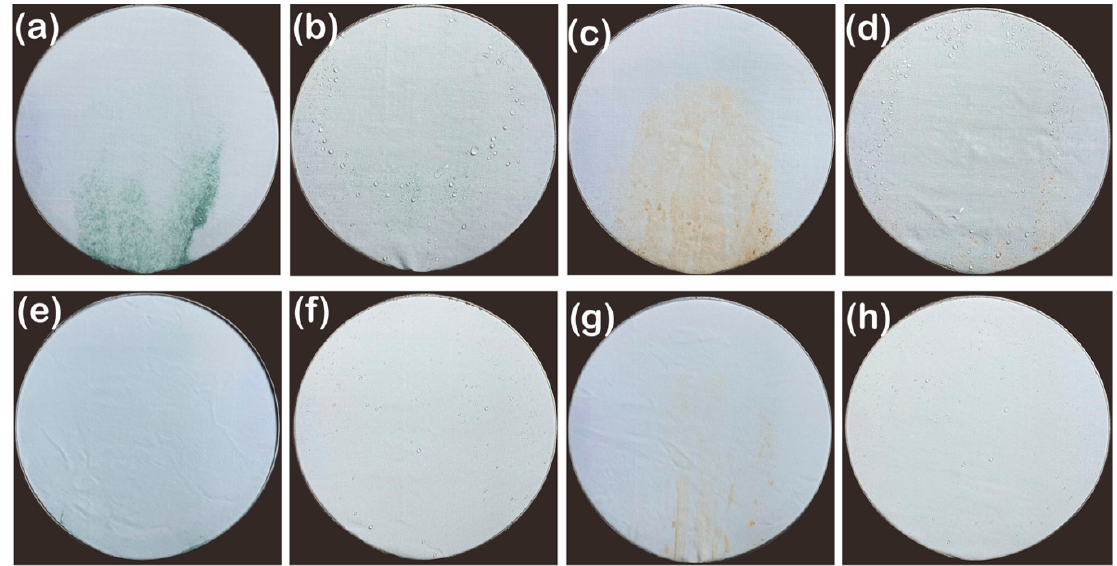
Figure 7. Self-cleaning tests combined with the water spray test of fabrics: untreated staple fabric ( a ) and P1T1 PDMS-coated staple fabric ( b ) contaminated with silicon carbides, untreated staple fabric ( c ) and P1T1 PDMS-coated staple fabric ( d ) contaminated with fine dusts, ( e ) untreated filament fabric ( e ), and P1T1 PDMS-coated filament fabric ( f ) contaminated with silicon carbides, untreated filament fabric ( g ), and P1T1 PDMS-coated filament fabric ( h ) contaminated with fine dusts.